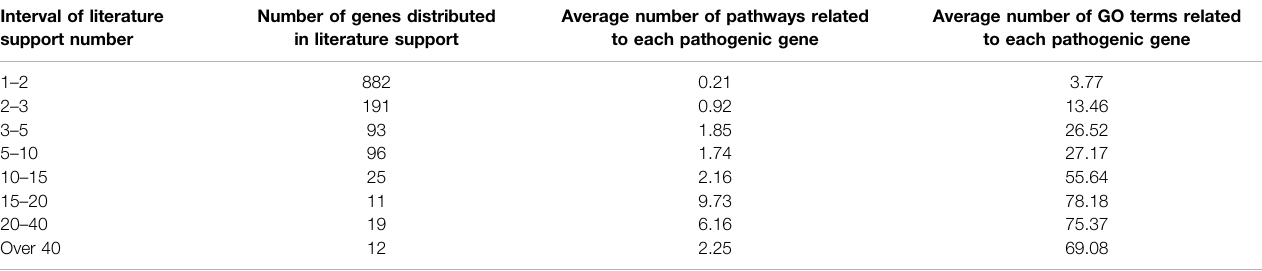
TABLE 1 | Analysis of documentary evidence of the pathogenic genes of